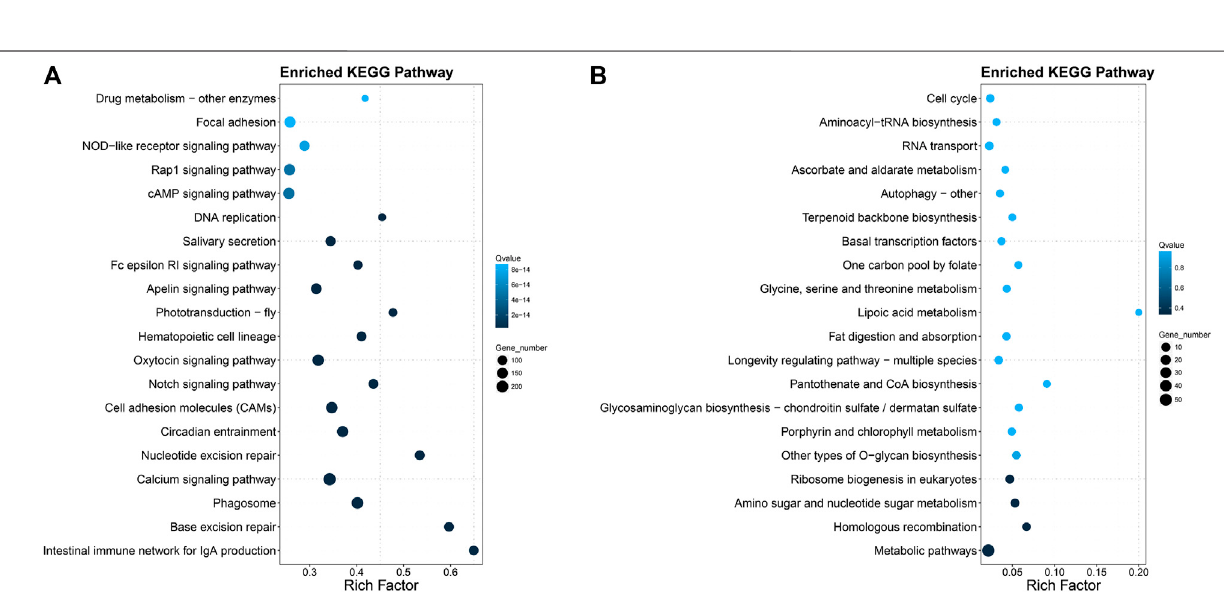
Frontiers in Genetics |